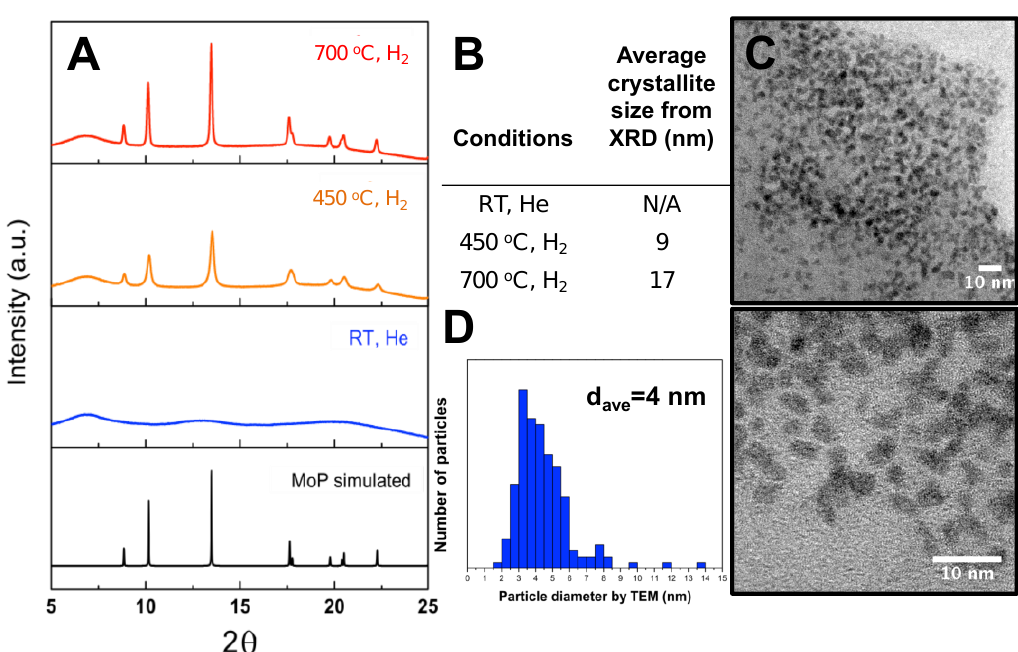
Figure 1. ( A ) In situ X-ray Diffraction (XRD) for unsupported molybdenum phosphide (MoP) nanoparticles during temperature programmed reduction. ( B ) Scherrer crystallite size analysis for unsupported MoP nanoparticles; ( C ) transmission electron microscopy (TEM) images for as-synthesized unsupported MoP nanoparticles; ( D ) particle size distribution from TEM using 163 particles.